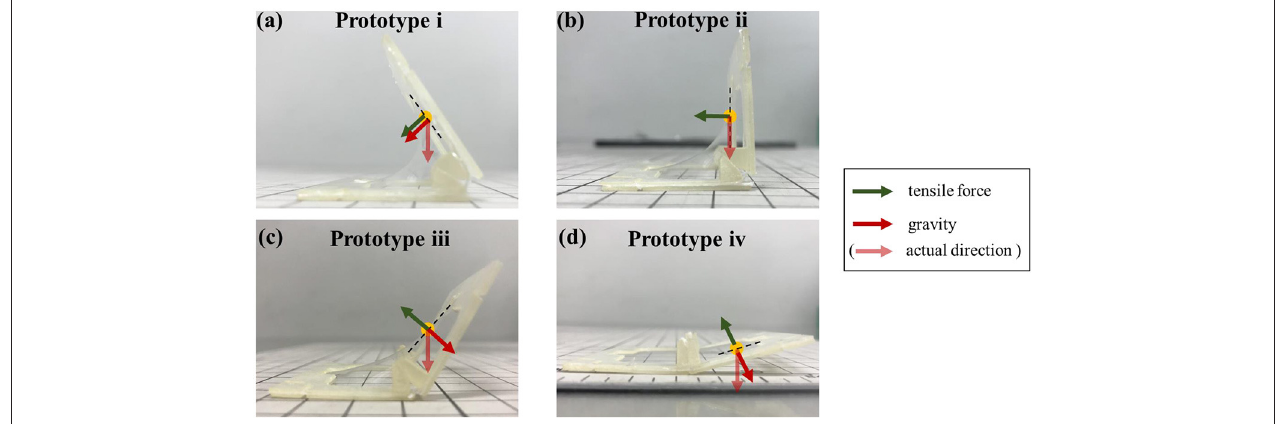
FIGURE 10 | Tension and gravity acting on each prototype. (a) In prototype i, the direction of the tensile force to self-fold and the direction of the gravity faces in the same direction. (b) In prototype ii, the directions of tension and gravity do not oppose each other. (c,d) As in the prototype iii and iv, when the target angle θ t is obtuse, the directions of tension and gravity oppose each other.